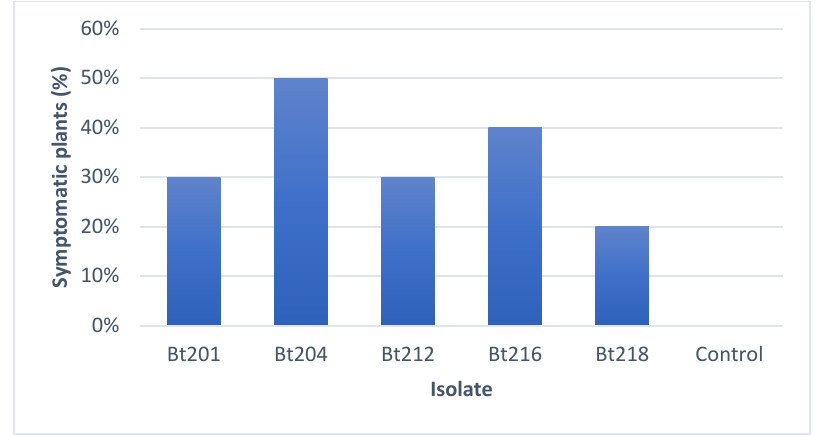
Figure 2. Percentage of plants showing symptoms on tendrils and leaves, after inoculation with the Botryosphaeriaceae isolates under study. Ten plants were used per isolate while control plants were sprayed with sterile distilled water.